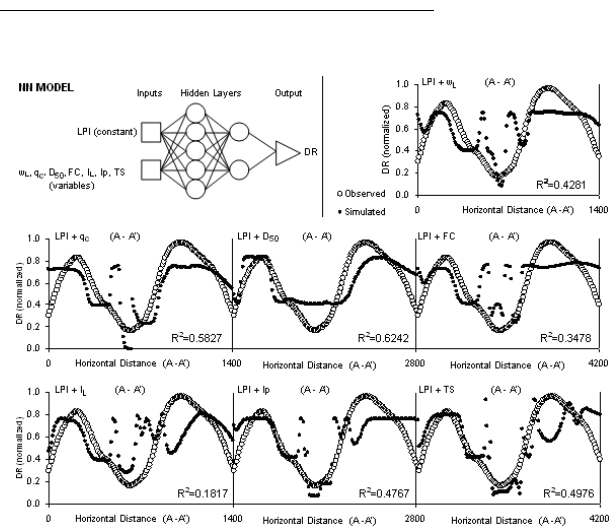
Fig. 7. The NN model used to select the effective parameters and the influence of each parameter in the solution of the